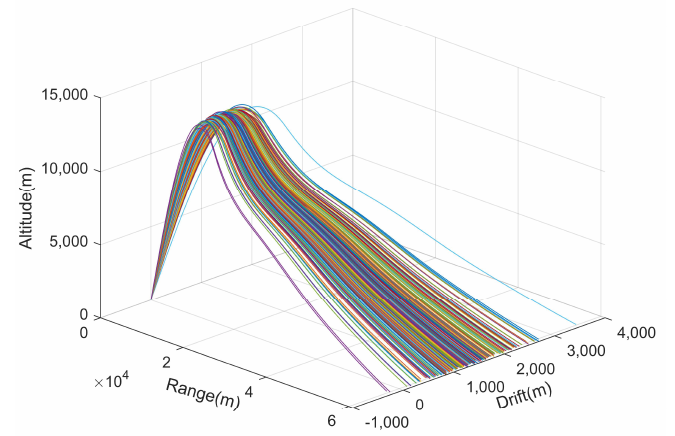
Figure 23. Unguided Rocket Trajectories.